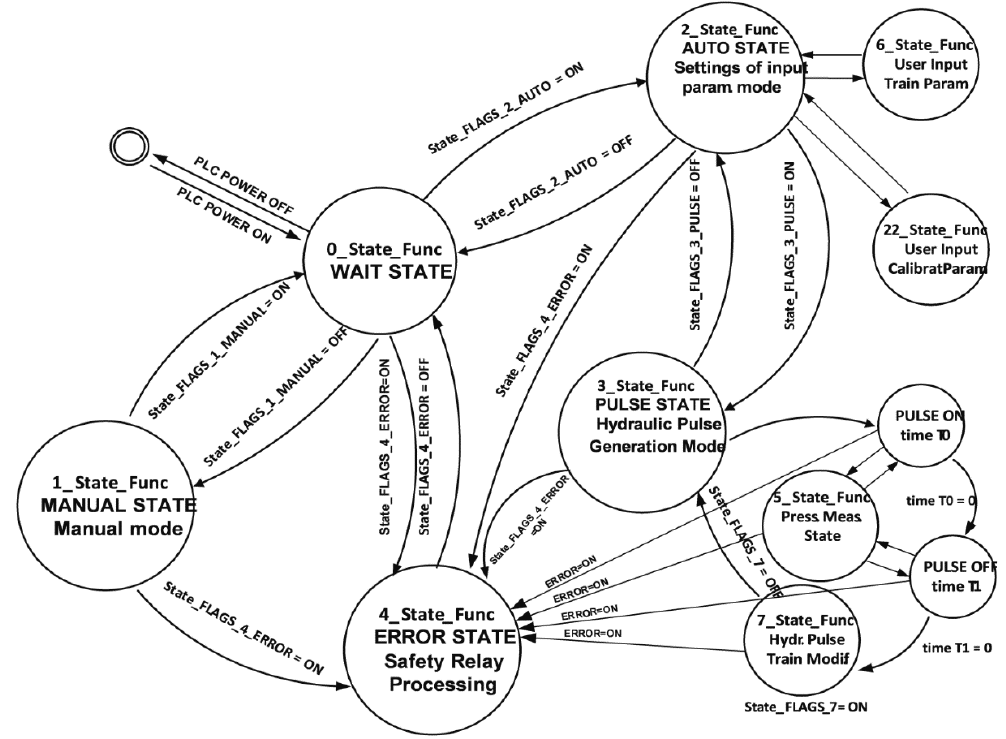
Figure 4. Master control state diagram for hydraulic pulse system consists of 7 separate threads running in the application layer, each thread represents the individual state of pneumatic–hydraulic pulsing system and is described in Table 3.